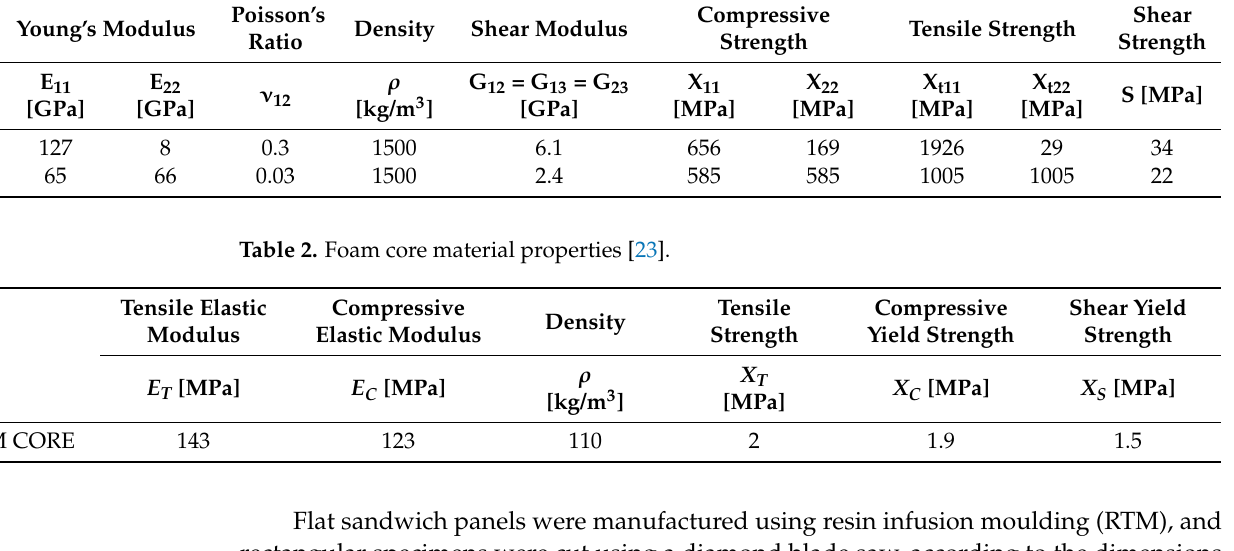
Table 1. Material properties for the CFRP skin material. For the UD ply, 1 is the direction of the fibres and 2 is the direction perpendicular to the fibres.